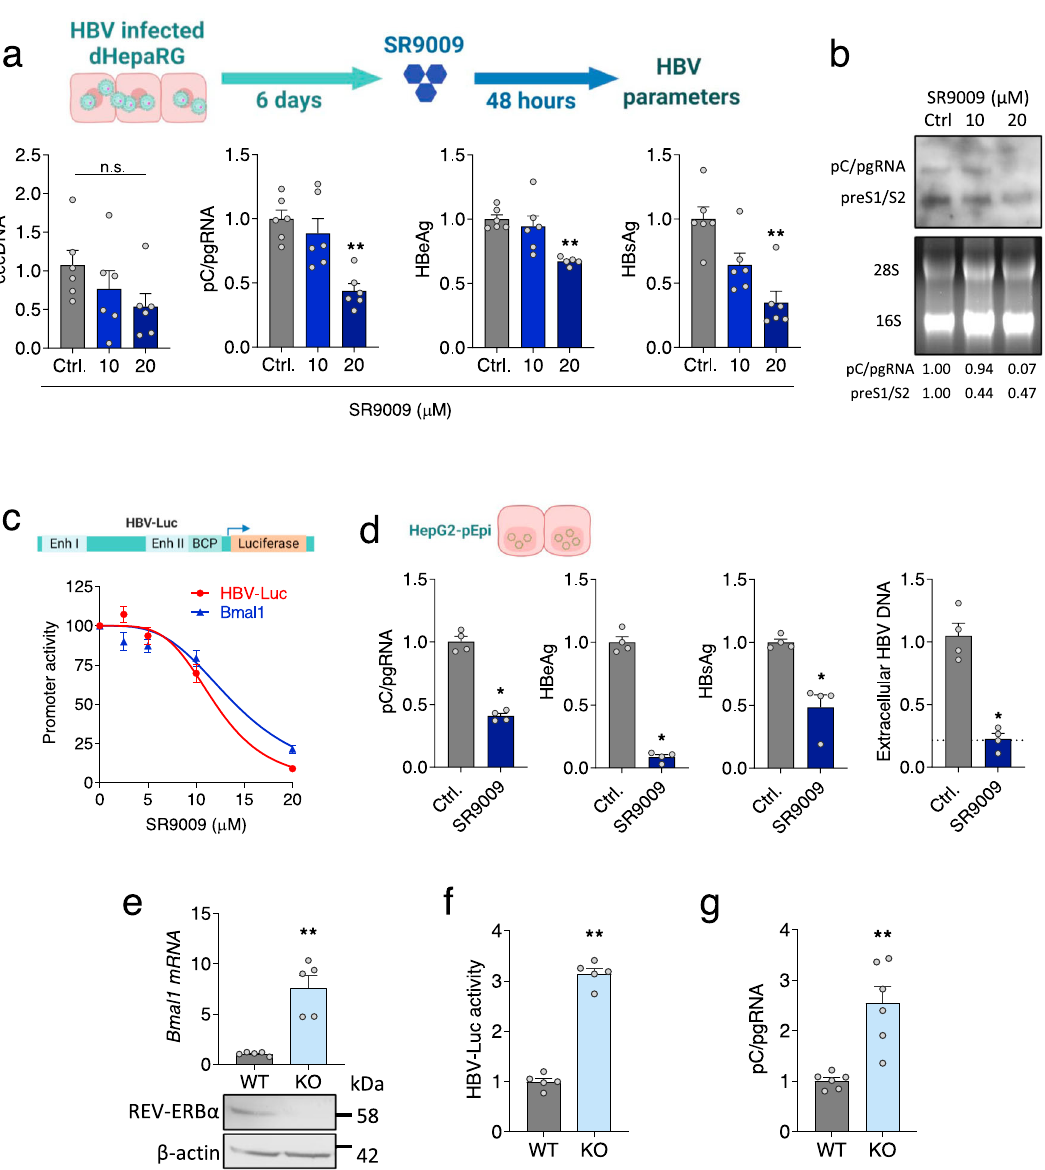
Fig. 4 REV-ERB α regulates HBV transcription. a dHepaRG cells were infected with HBV for 6 days followed by SR9009 treatment (10 or 20 µ M) for 48 h. HBV parameters: cccDNA, pC/gRNA, HBeAg and HBsAg were determined by qRT-PCR or ELISA assays. In all cases, data are expressed relative to untreated (Ctrl) cells (mean ± SEM, n = 6, Kruskal – Wallis ANOVA with Dunn ’ s test). b HBV transcripts in the SR9009 treated dHepaRG cells were quanti fi ed by northern blotting. Densitometric analysis quanti fi ed pC/pgRNA and preS1/S2 transcripts and was normalized to the 28 S and 18 S rRNA loading controls. c HepG2-NTCP cells were transfected with HBV EnhI/II-BCP or Bmal1 promoter luciferase reporters for 48 h and treated with SR9009 for 24 h and promoter activity quanti fi ed by measuring luciferase activity (mean ± SEM, n = 4 – 6). d HepG2-pEpi cells were treated with SR9009 (20 µ M) for 48 h. HBV parameters: pC/pgRNA, HBsAg, HBeAg and extracellular particle HBV DNA were determined by qRT-PCR or ELISA assays. The reverse transcriptase inhibitor Entecavir (ETV, 1 μ M) was included as positive control for the genesis of de novo particles and is represented by the dashed line. In all cases, data are expressed relative to untreated (Ctrl) cells (mean ± SEM, n = 4, Mann – Whitney test, Two-sided). e Parental (WT) or Rev-erb α KO HepG2-NTCP cell lysates were assessed for REV-ERB α expression together with housekeeping gene β -actin by western blotting. Total RNA was extracted and Bmal1 mRNA levels measured by qRT-PCR. Data are expressed relative to WT cells (mean ± SEM, n = 5, Mann – Whitney test, Two-sided). f WT or Rev- erb α KO cells were co-transfected with HBV BCP luciferase reporter and Renilla luciferase reporter and 48 h post transfection the cells lysed and luciferase activity quanti fi ed. Data are expressed relative to WT (mean ± SEM, n = 5, Mann – Whitney test, Two-sided) and the data normalized for